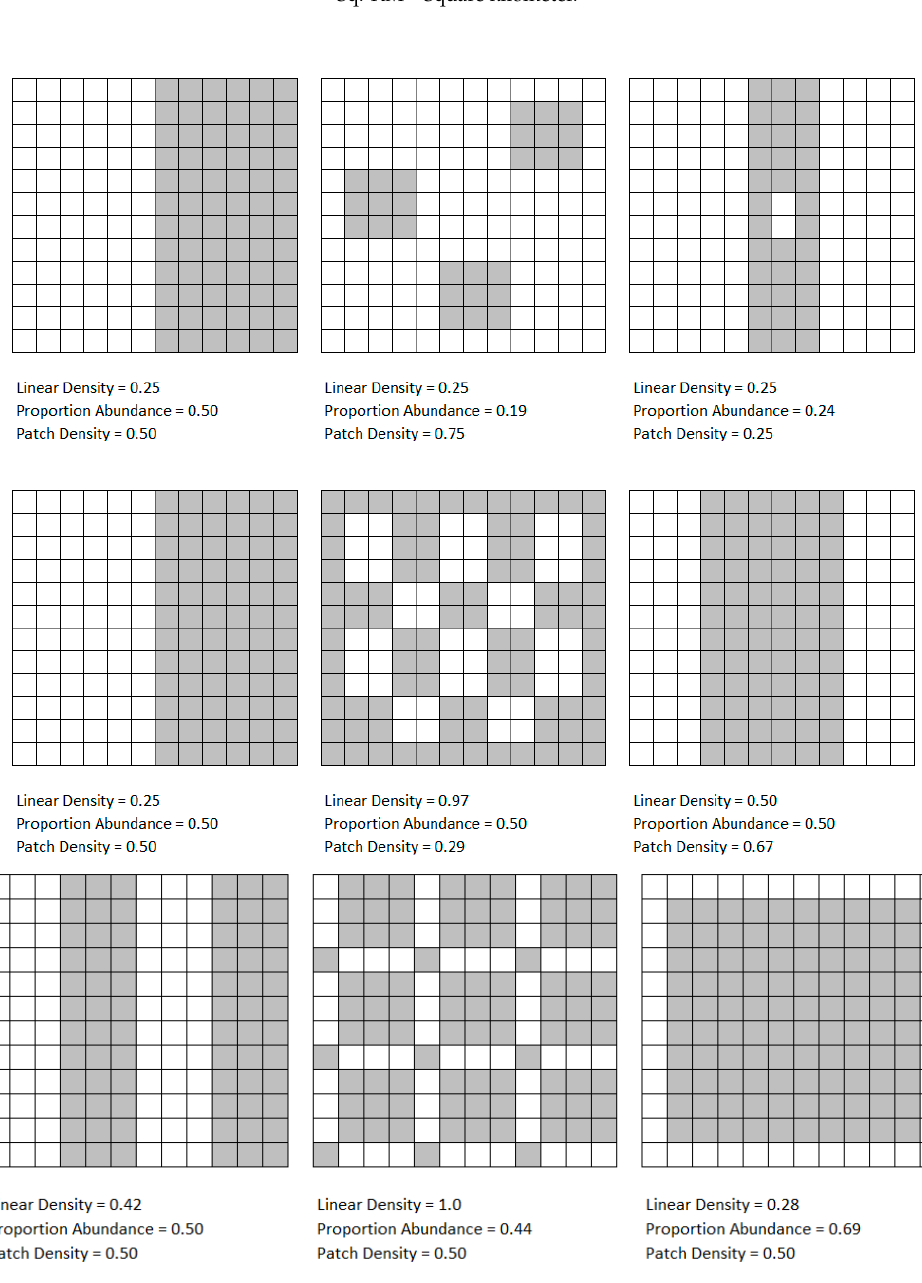
Figure 1. Relationship between linear density, proportion abundance, and patch density.